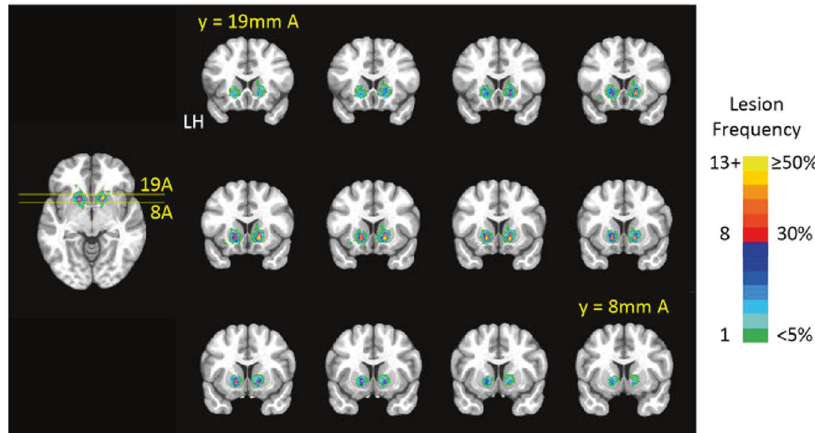
Fig. 3 Lesion locations. Heat maps represent the location of lesions linearly transformed onto the standard MNI152 1 mm brain template. Colors indicate lesion frequency for each voxel, in terms of the number (left side of the color bar) or percent (right side of the color bar) of patients. LH: Left hemisphere. Slice labels indicate y (anterior – posterior) position in mm anterior (A) to the anterior commissure.